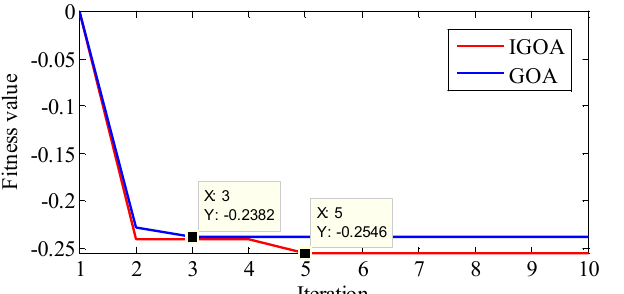
has higher convergence accuracy. shows that IGOA